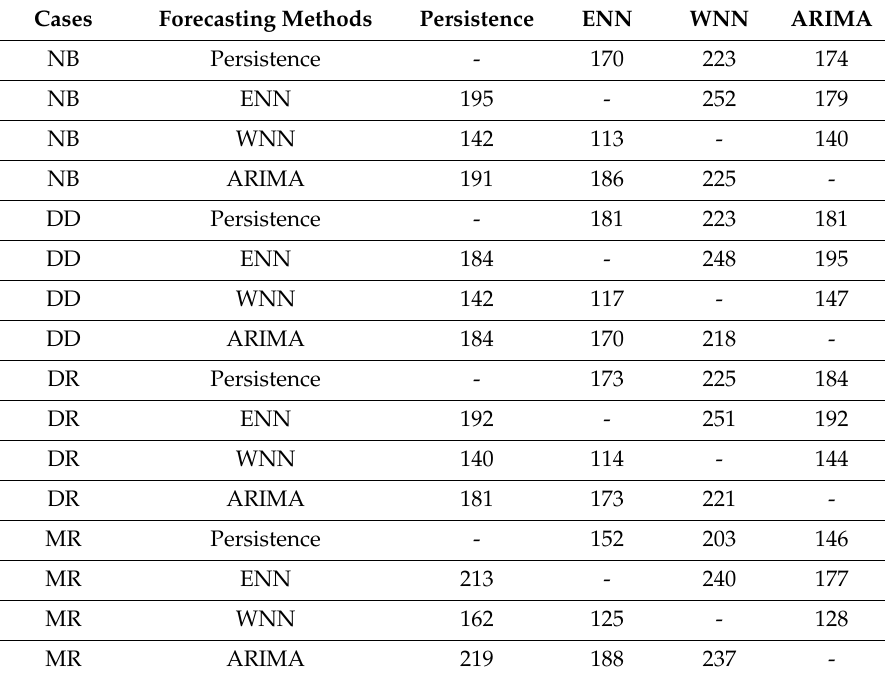
Table 8. The number of days when the method in the row outperforms that in the column in di ff erent